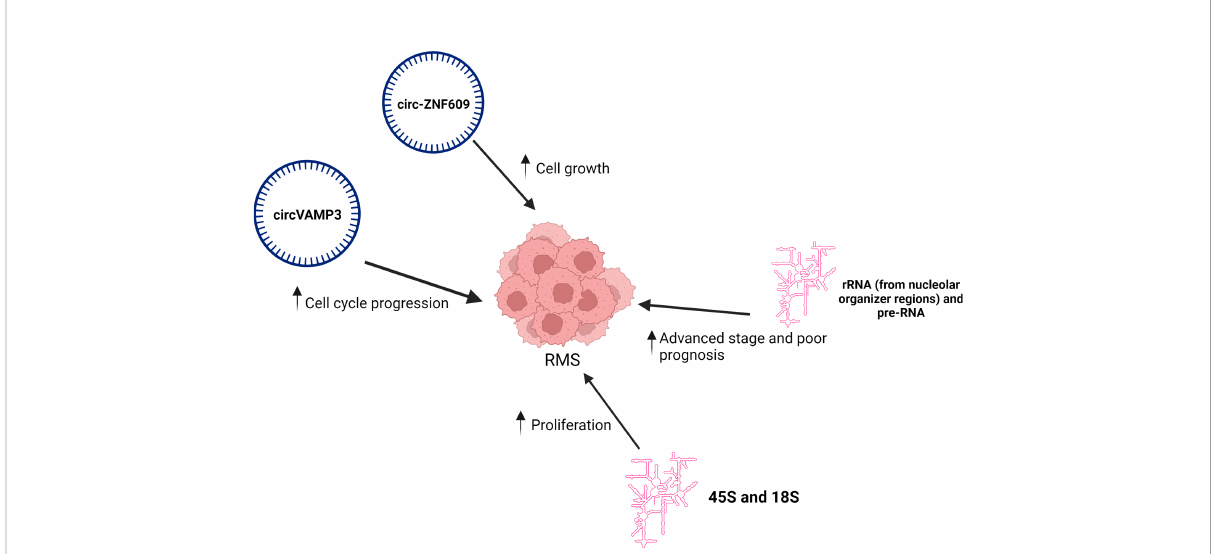
FIGURE 4 CircRNA and rRNA implicated in RMS biology. Schematic representation of circ-ZNF609 and circVAMP3 upregulating RMS cell growth and proliferation, respectively; rRNA from nucleolar organizer regions and pre-RNA correlated with advanced stage and poor prognosis of RMS; as well as ribosomal subunits 45S and 18S promoting RMS proliferation. Created with